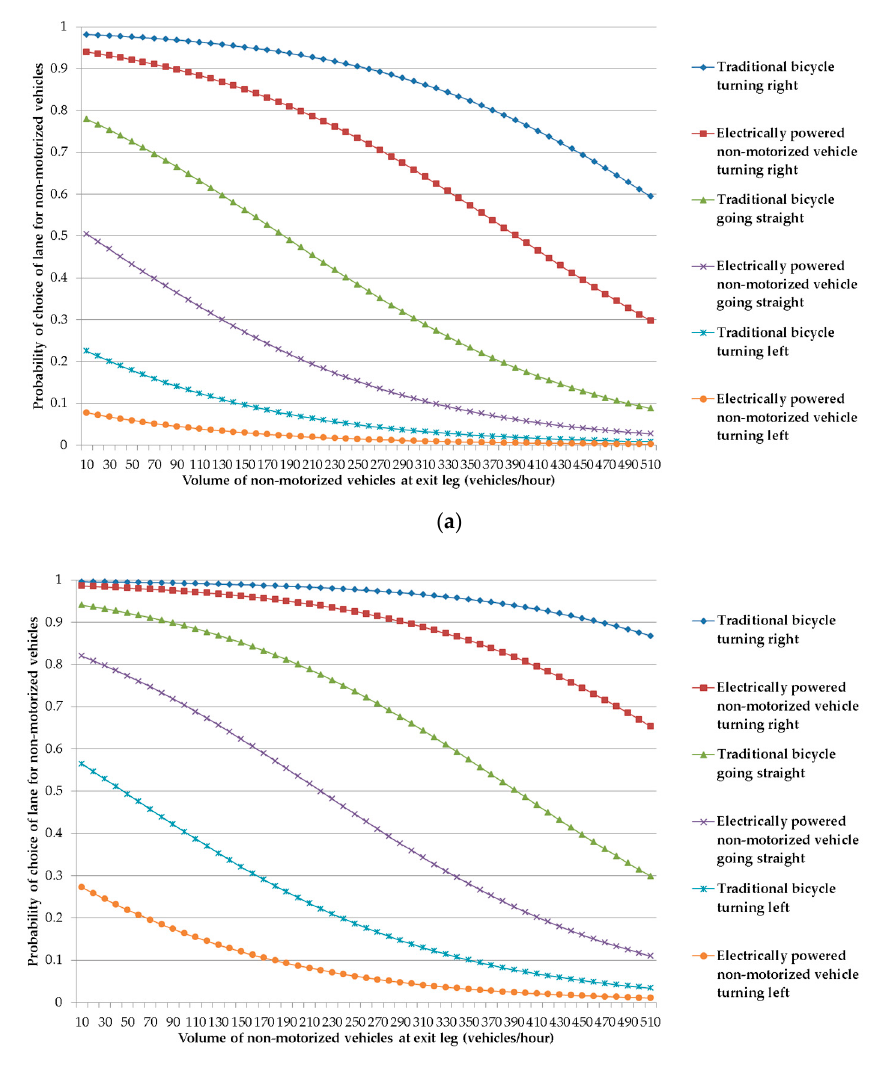
Figure 4. Probability curves of lane choice of male riders of non-motorized vehicles. ( a ): Width of lane for non-motorized vehicles being 1.5 m; ( b ): width of lane for non-motorized vehicles being 3.75